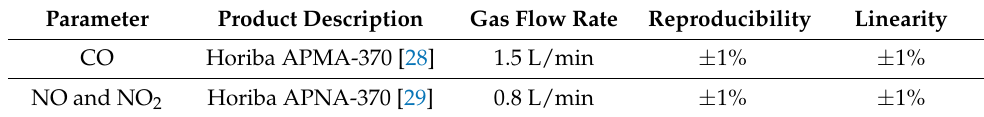
Table 5. Equipment used at the reference measuring station.